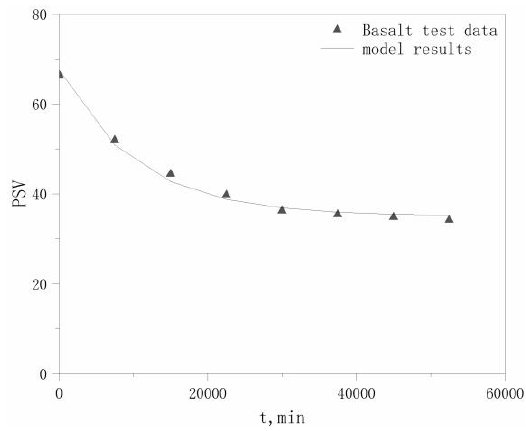
Fig. 7 Modeled and tested PSV results for limestone.